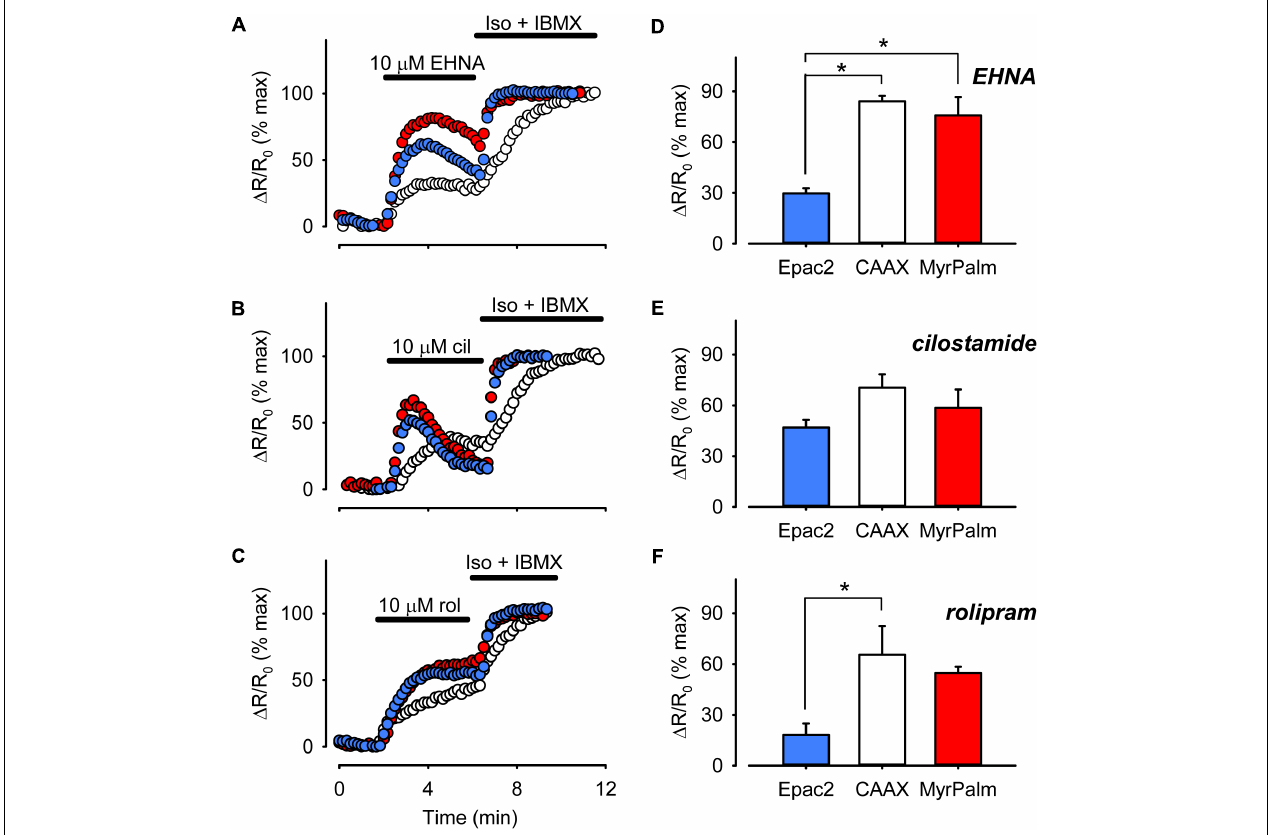
FIGURE 7 | Differential PDE activity is associated with different microdomains. (A–C) Representative time course of changes in the magnitude of the normalized FRET response ( (cid:49) R/R 0 ) recorded in cells expressing Epac2-camps (Epac2, blue circles), Epac2-CAAX (CAAX, white circles), and Epac2-MyrPalm (MyrPalm, red circles) under control conditions and following exposure to the selective PDE2 inhibitor EHNA (A) , the selective PDE3 inhibitor cilostamide (B) , or the selective PDE4 inhibitor rolipram (C) . The maximal response was elicited by subsequent exposure to 1 µ M Iso plus 100 µ M IBMX (Iso + IBMX). (D–F) Comparison of average changes in normalized FRET responses detected by Epac2-camps (blue bars), Epac2-CAAX (white bars), and Epac2-MyrPalm (red bars) following treatment with 10 µ M EHNA (n/N = 5/3, Epac2; 5/3, CAAX; 5/3, MyrPalm; D ), 10 µ M cilostamide (n/N = 6/4, Epac2; 7/3, CAAX; 6/3, MyrPalm; E ), or 10 µ M rolipram (n/N = 6/4, Epac2; 5/3, CAAX; 6/3, MyrPalm; F ) ( ∗ p < 0.05, Kruskal–Wallis one-way ANOVA on Ranks followed by Dunn’s test for pairwise multiple